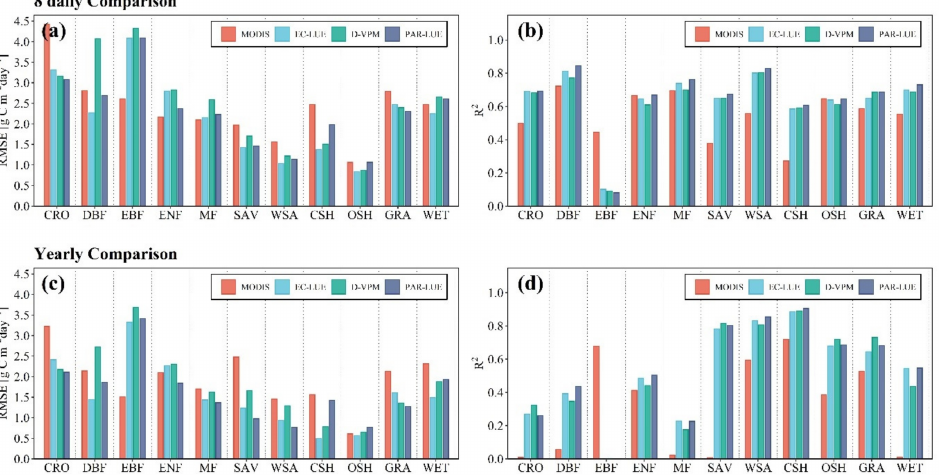
Figure 6. Accuracy comparison of GPP estimated from different LUE models in different vegeta- tion types. ( a ) Comparison of RMSE at the 8-day scale, ( b ) comparison of R 2 at the 8-day scale, ( c ) comparison of RMSE at the yearly scale, and ( d ) comparison of R 2 at the yearly